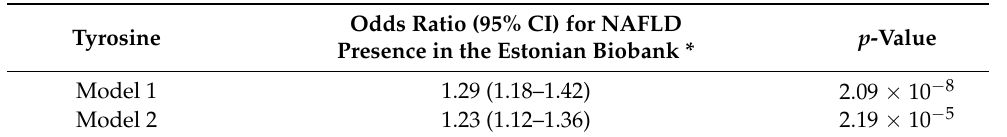
Table 2. Association of plasma tyrosine levels (SD) with the presence of non-alcoholic fatty liver disease in the Estonian Biobank.